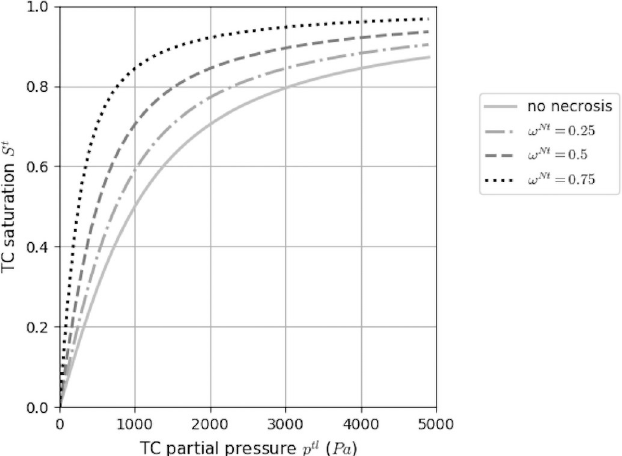
Fig 3. Constitutive relationship between tumor cell partial pressure and saturation. Tumor cell phase saturation S t , with the parameter a (fixed to 1kPa in the figure), evolving with the necrotic fraction of the phase o � Nt .